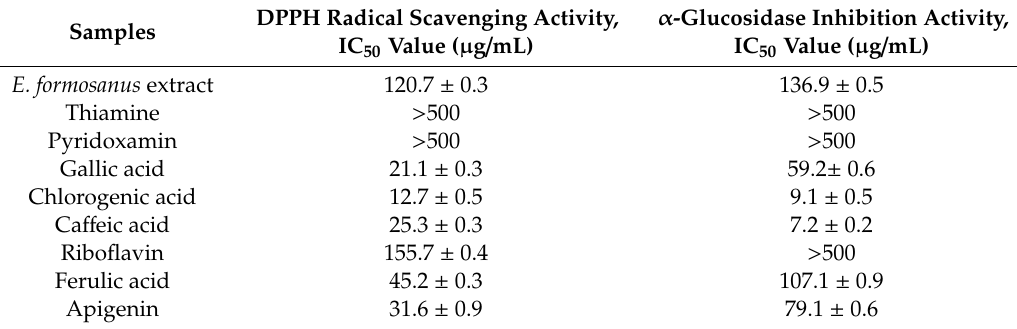
Table 5. Antioxidant activities and α -glucosidase inhibition activity of E. formosanus extract.